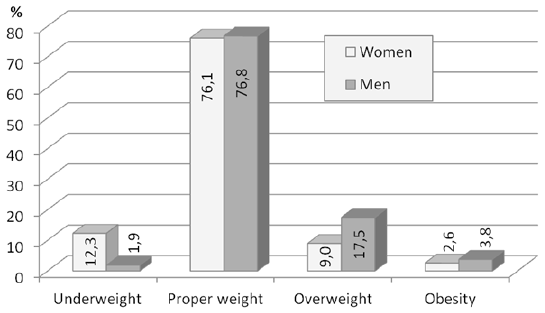
Figure 1. The distribution of BMI classes in males and females (N=1517).